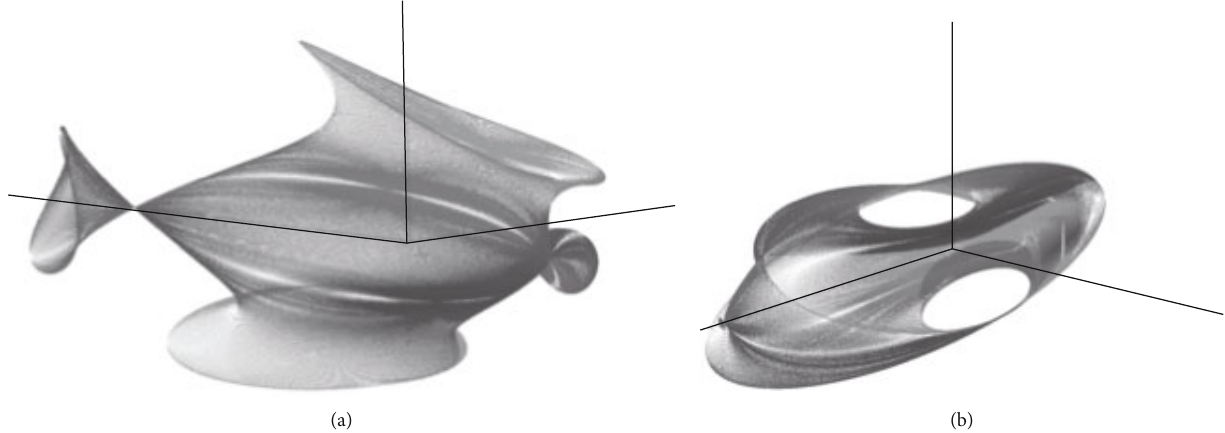
Figure 15: The wave front at t = 14 : 0 (a) and t = 19 : 0 (b). The separated portion of the wave front at t = 13 has rejoined the main section. This section rotates, collapses in pinch points, and eventually pulls apart as previously.